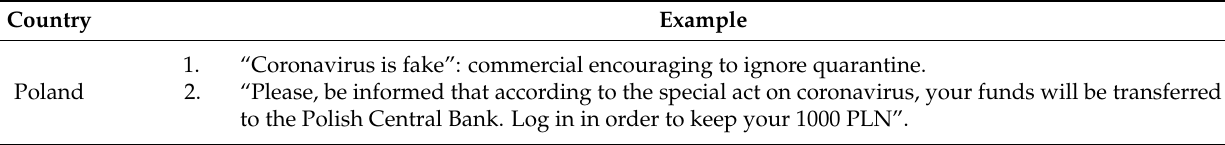
Table 4. Examples of debunked fake